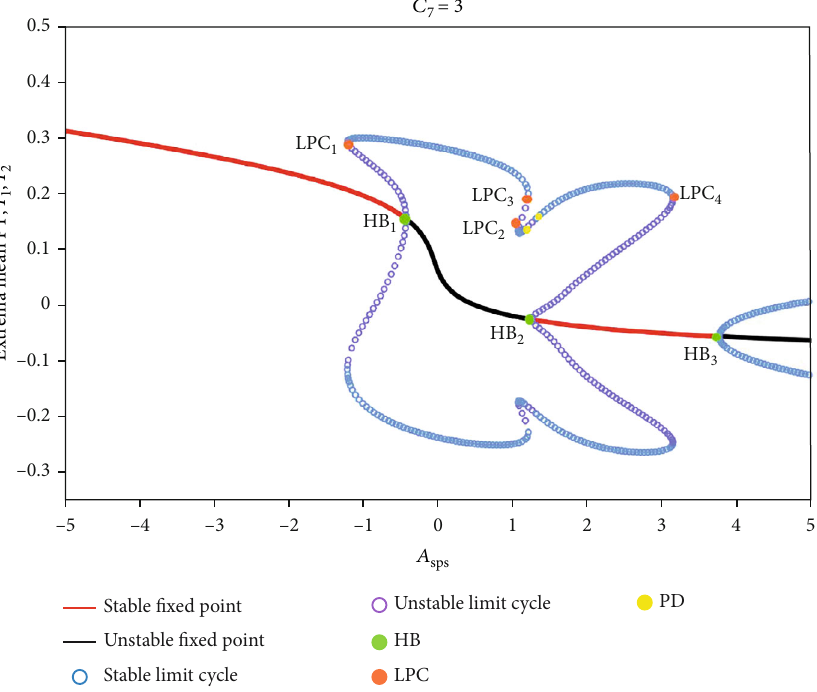
Figure 7: Dynamical analysis corresponding to the state transitions in Figure 7(e). As A fold of cycle bifurcation (LPC bifurcation